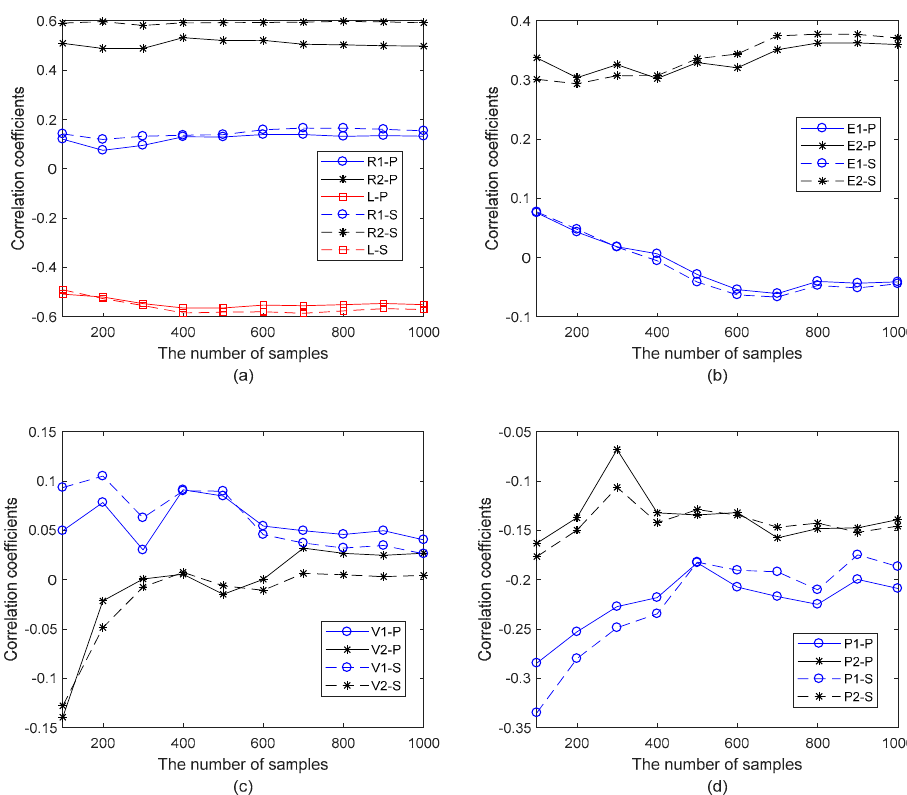
Figure 8. The correlation coefficients of geometrical and material parameters in the finite plane element model of graphene. ( a ) is for the geometrical parameters R1, R2 and L; ( b ) is for the material parameters E1 and E2; ( c ) is for the material parameters v1 and v2; ( d ) is for the material parameters P1 and P2